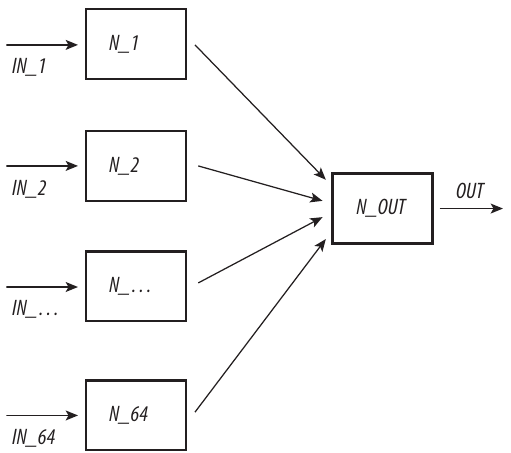
Fig. 2. Structure of the artificial neural network